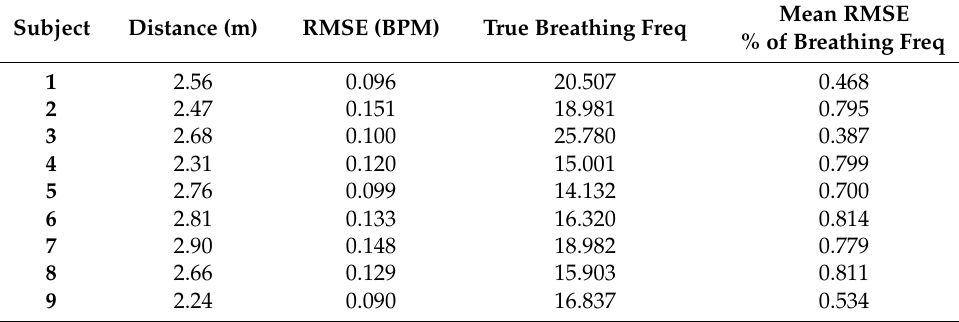
Table 6. Root mean squared error results on test subjects for ranges 2–3 m.